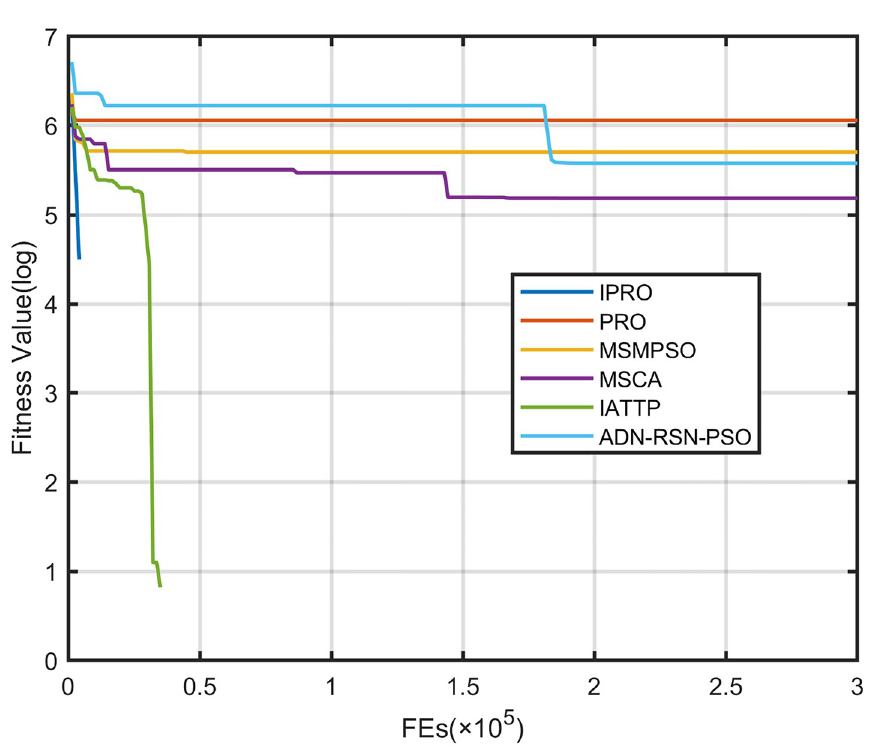
Fig 12. Convergence curves on